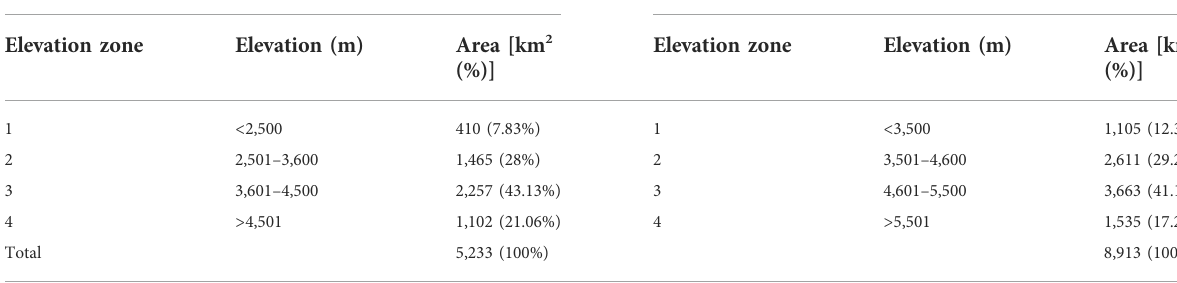
TABLE 2 Statistical details of topographic parameters for Astore and